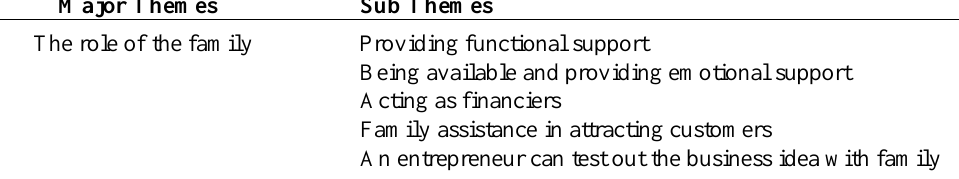
Table 2: Themes Derived from Research Participants' Narratives Major